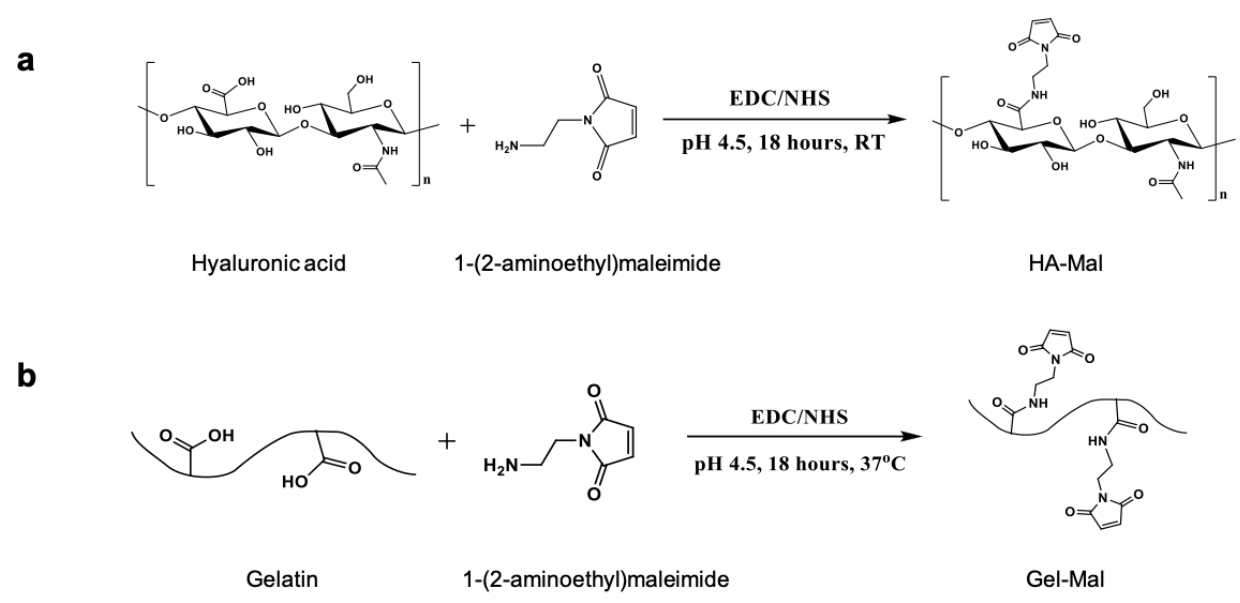
Figure 1. Reaction schemes of the EDC/NHS activated syntheses of ( a ) HA-Mal and ( b ) Gel-Mal.